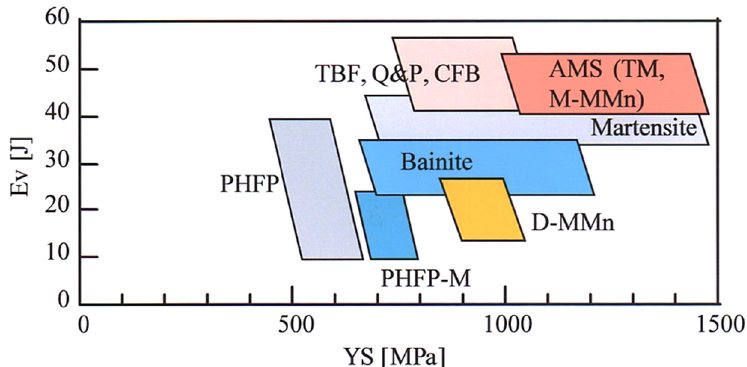
Figure 17. Relationship between Charpy V-notch impact value ( E v ) and yield stress (YS) at room temperature in steel groups [77,117,141–146]. PHFP, PHFP-M, TBF, Q&P, CFB, D-MMn, AMS, TM and M-MMn are precipitation-hardening ferritic–pearlitic, micro-alloyed PHFP, TRIP-aided bainitic ferrite, quenching and partitioning, carbide-free bainitic, duplex-type medium Mn, advanced marten- sitic, TRIP-aided martensitic, and martensite-type medium Mn steels, respectively. This figure is reproduced based on Ref. [117].